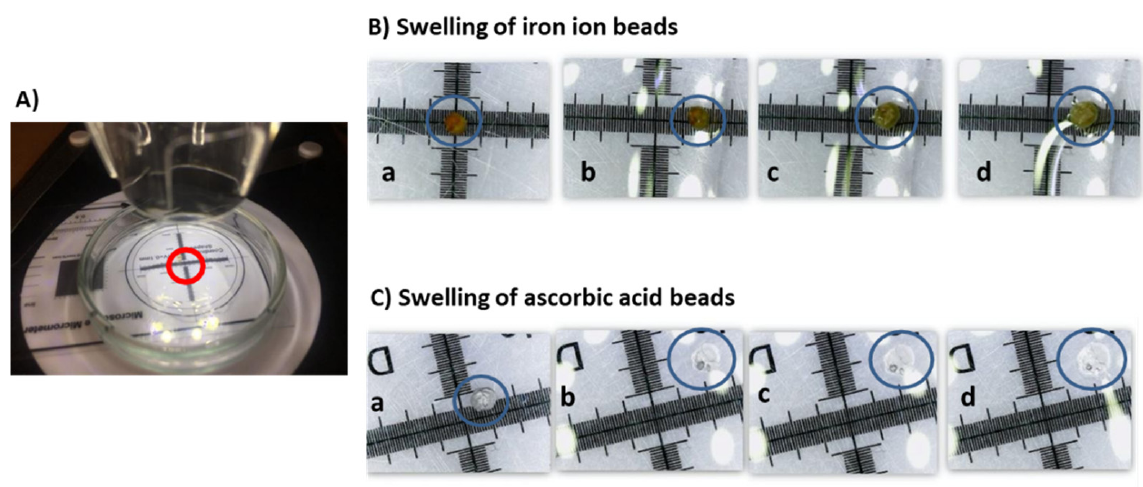
Figure 2. ( A ) Crucible containing the bead and the liquid phase to analyze the swelling by a microscope; ( B ) Swelling of an iron ion bead at pH 4.7 at the following times: (a) 0 min; (b) 0.367 min; (c) 6 min; (d) 30 min; ( C ) Swelling of an ascorbic acid bead at pH 4.7 at the following times: (a) 0 min; (b) 0.6 min; (c) 4 min; (d) 30 min.